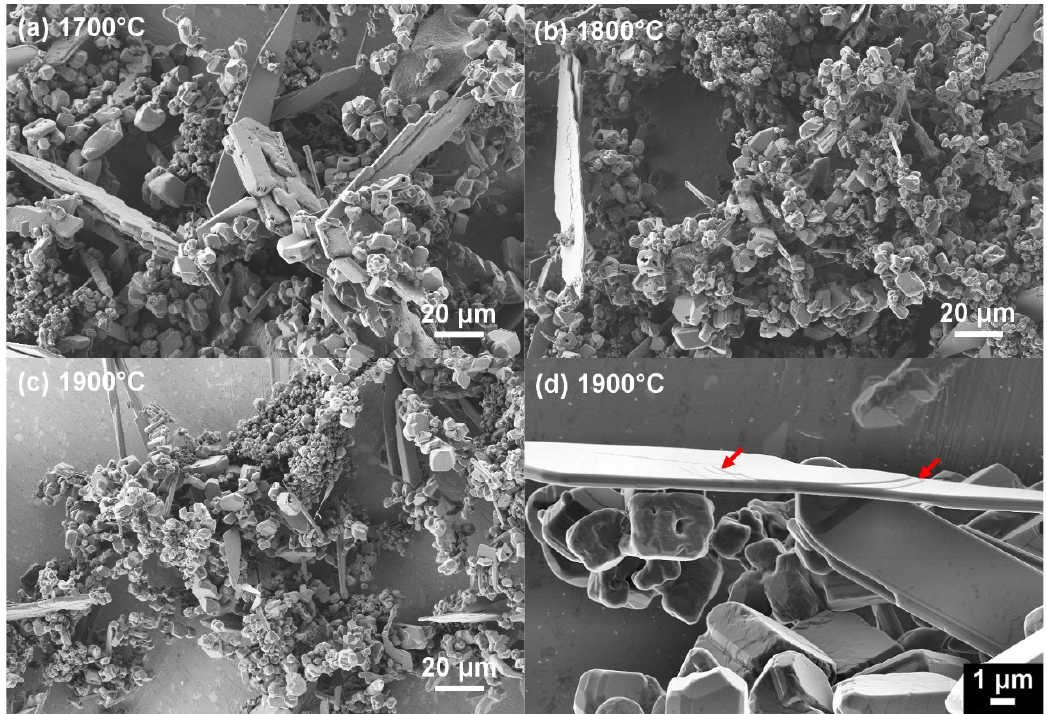
Figure 4. SEM micrographs of powders synthesized at different temperatures for 20 min from a mixture with a molar ratio of B 2 O 3 /C = 0.75:1, ( a ) 1700 °C, ( b ) 1800 °C, ( c ) and ( d ) 1900 °C, the arrows in ( d ) indicate the layered structure of synthesized boron carbide.